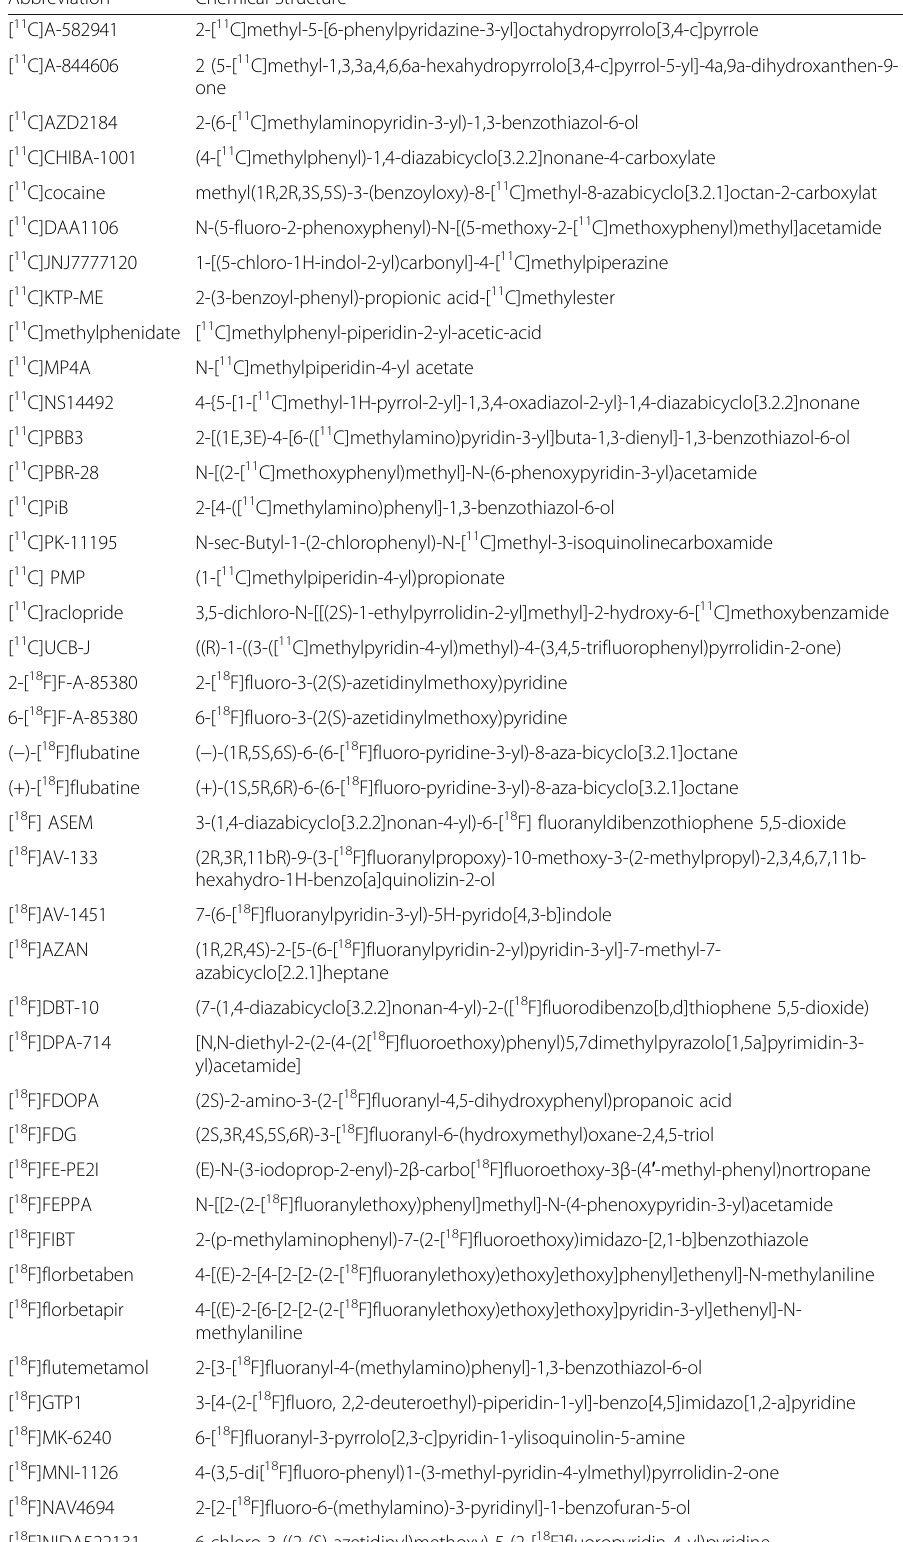
Table 2 Chemical structures of all radiotracers